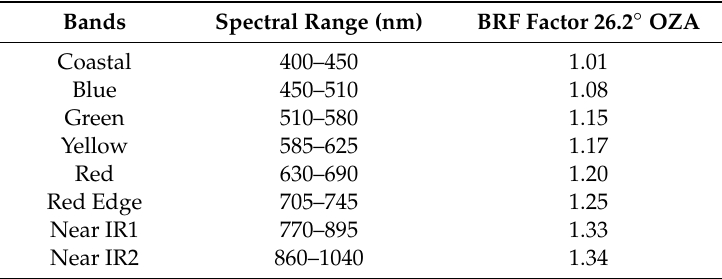
BRF Correction factors for the WorldView-3 Imagery. Values were derived from Breunig et al. [41] and represent backscatter viewing conditions. Dividing the observed reflectance by the BRF correction factors derives the on-nadir surface reflectance. OZA = Observation Zenith